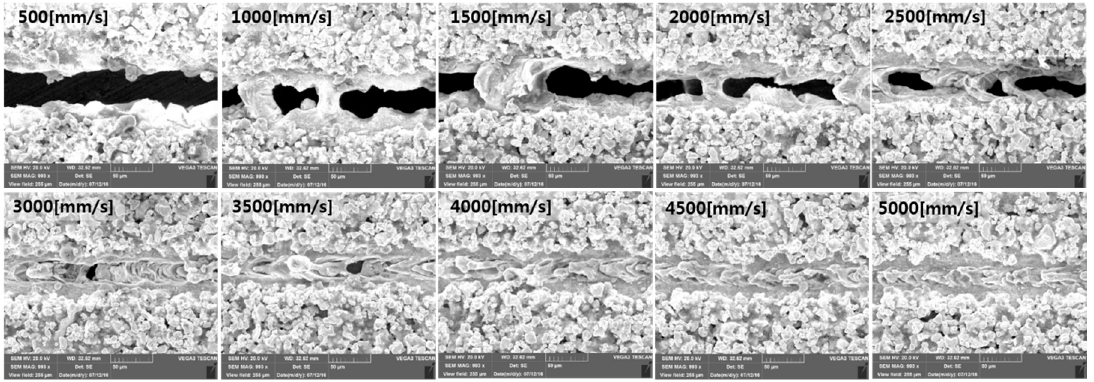
Figure 11. Result of one-dimensional semi-infinite conduction model. Figure 13. SEM image with a laser power of 100 W. Figure 13. SEM image with a laser power of 100 W.